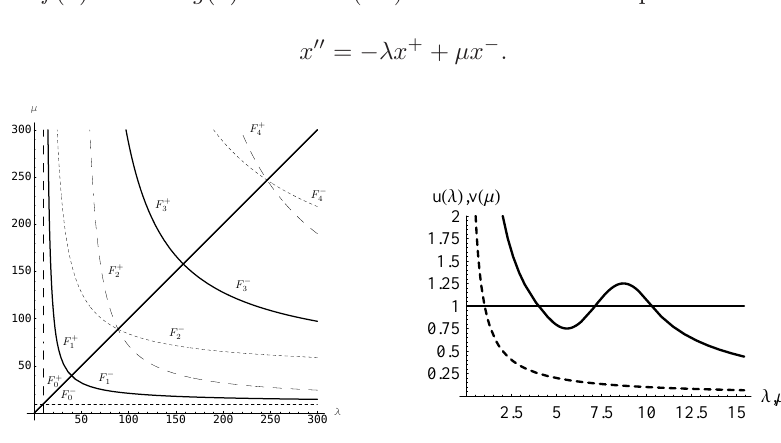
containing two functions f and g . Here x + = max and λ, µ are nonnegative parameters. Functions f and g are continuous positive valued for x > 0 and f (0) = g (0) = 0 .